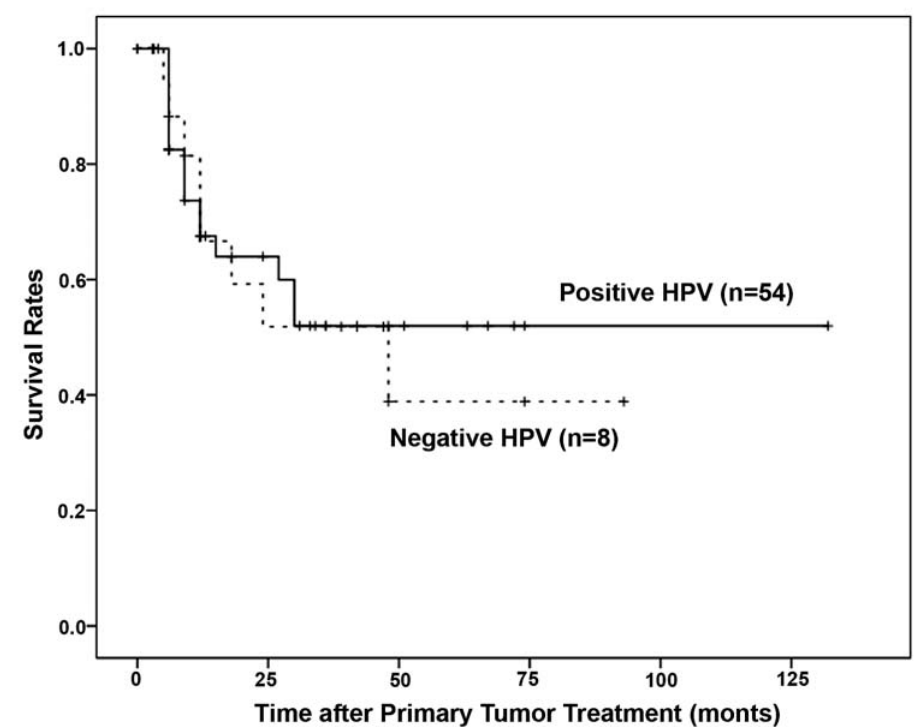
Figure 2 – (cid:53)(cid:72)(cid:86)(cid:83)(cid:72)(cid:70)(cid:87)(cid:76)(cid:89)(cid:72)(cid:3)(cid:20)(cid:19)(cid:16)(cid:92)(cid:72)(cid:68)(cid:85)(cid:3)(cid:86)(cid:88)(cid:85)(cid:89)(cid:76)(cid:89)(cid:68)(cid:79)(cid:3)(cid:85)(cid:68)(cid:87)(cid:72)(cid:86)(cid:3)(cid:68)(cid:70)(cid:70)(cid:82)(cid:85)(cid:71)(cid:76)(cid:81)(cid:74)(cid:3)(cid:87)(cid:82)(cid:3)(cid:87)(cid:75)(cid:72)(cid:3)(cid:83)(cid:85)(cid:72)(cid:86)(cid:72)(cid:81)(cid:70)(cid:72)(cid:3)(cid:11)(cid:81)(cid:3)(cid:32)(cid:3)(cid:24)(cid:23)(cid:12)(cid:3)(cid:82)(cid:85)(cid:3)(cid:68)(cid:69)(cid:86)(cid:72)(cid:81)(cid:70)(cid:72)(cid:3)(cid:82)(cid:73)(cid:3)(cid:43)(cid:88)(cid:80)(cid:68)(cid:81)(cid:3)(cid:51)(cid:68)(cid:83)(cid:76)(cid:79)(cid:79)(cid:82)(cid:80)(cid:68)(cid:89)(cid:76)(cid:85)(cid:88)(cid:86)(cid:3)(cid:11)(cid:81)(cid:3)(cid:32)(cid:3)(cid:20)(cid:27)(cid:12)(cid:17)(cid:3)(cid:46)(cid:68)(cid:83)(cid:79)(cid:68)(cid:81)(cid:16)